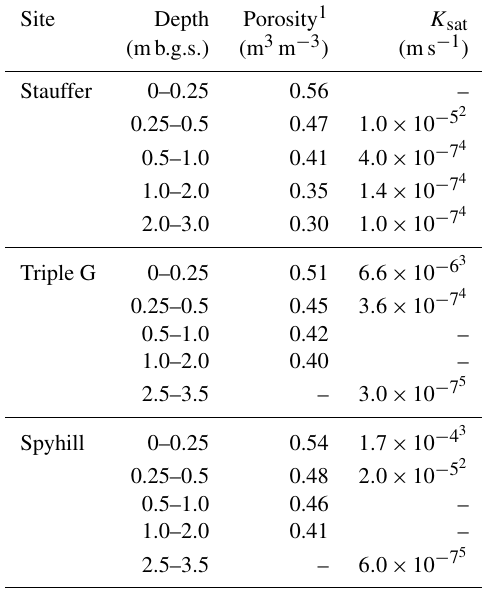
Table 2. Measurements of soil porosity and unfrozen saturated hy- draulic conductivity ( K sat ) at various depths at the study